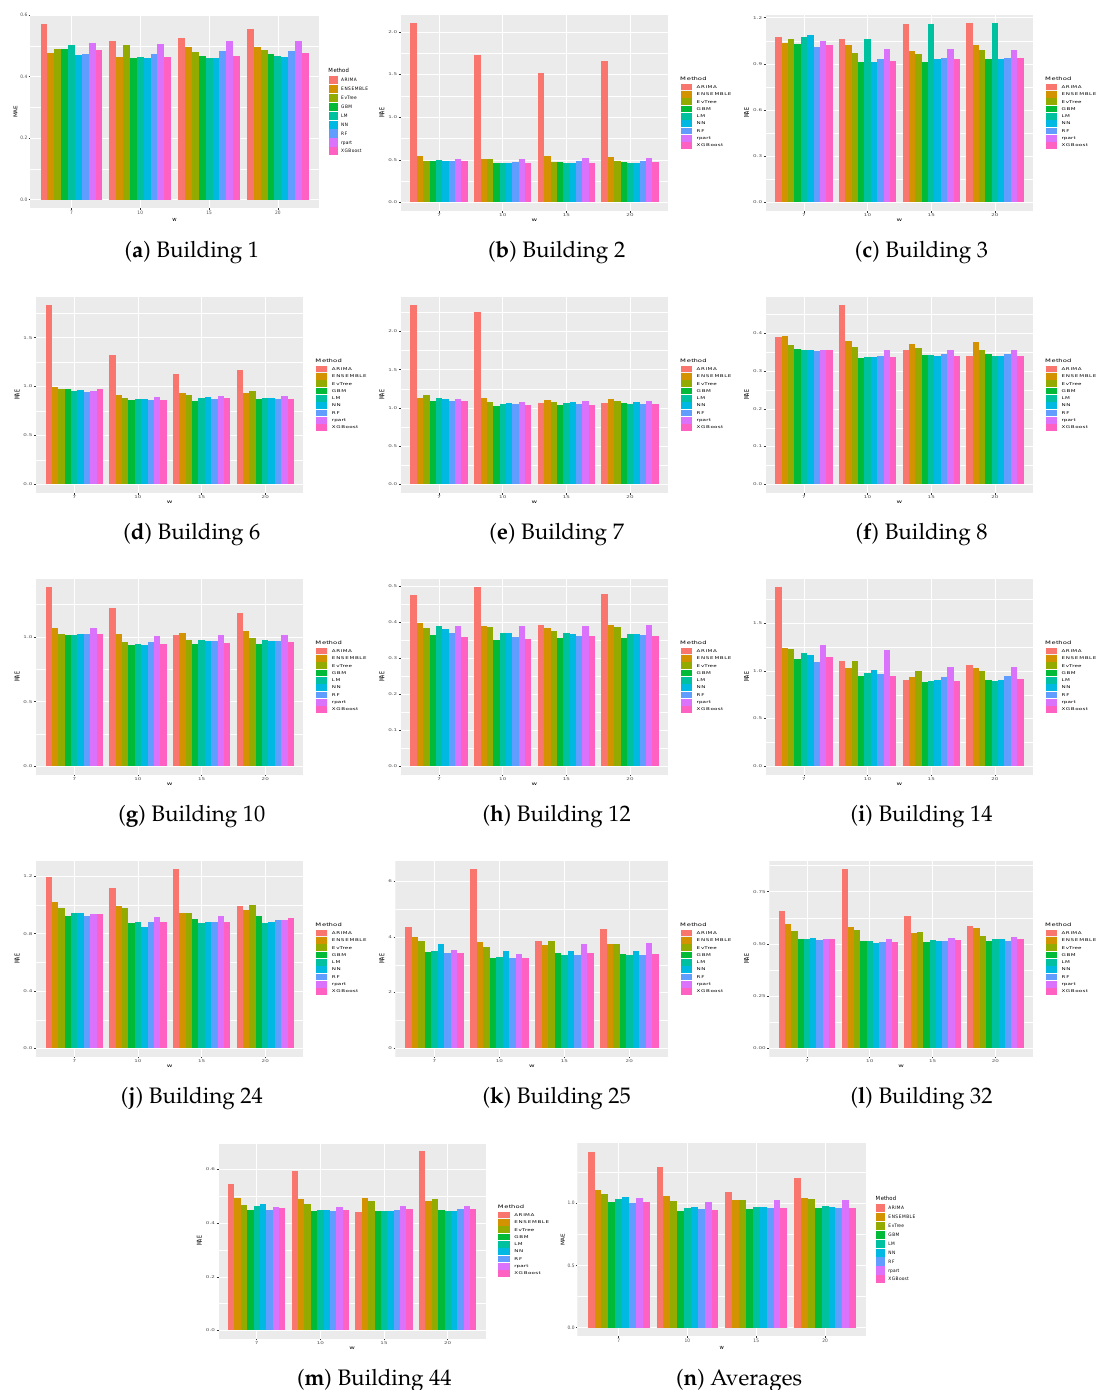
Figure A1. Comparison of the MAE obtained on the various